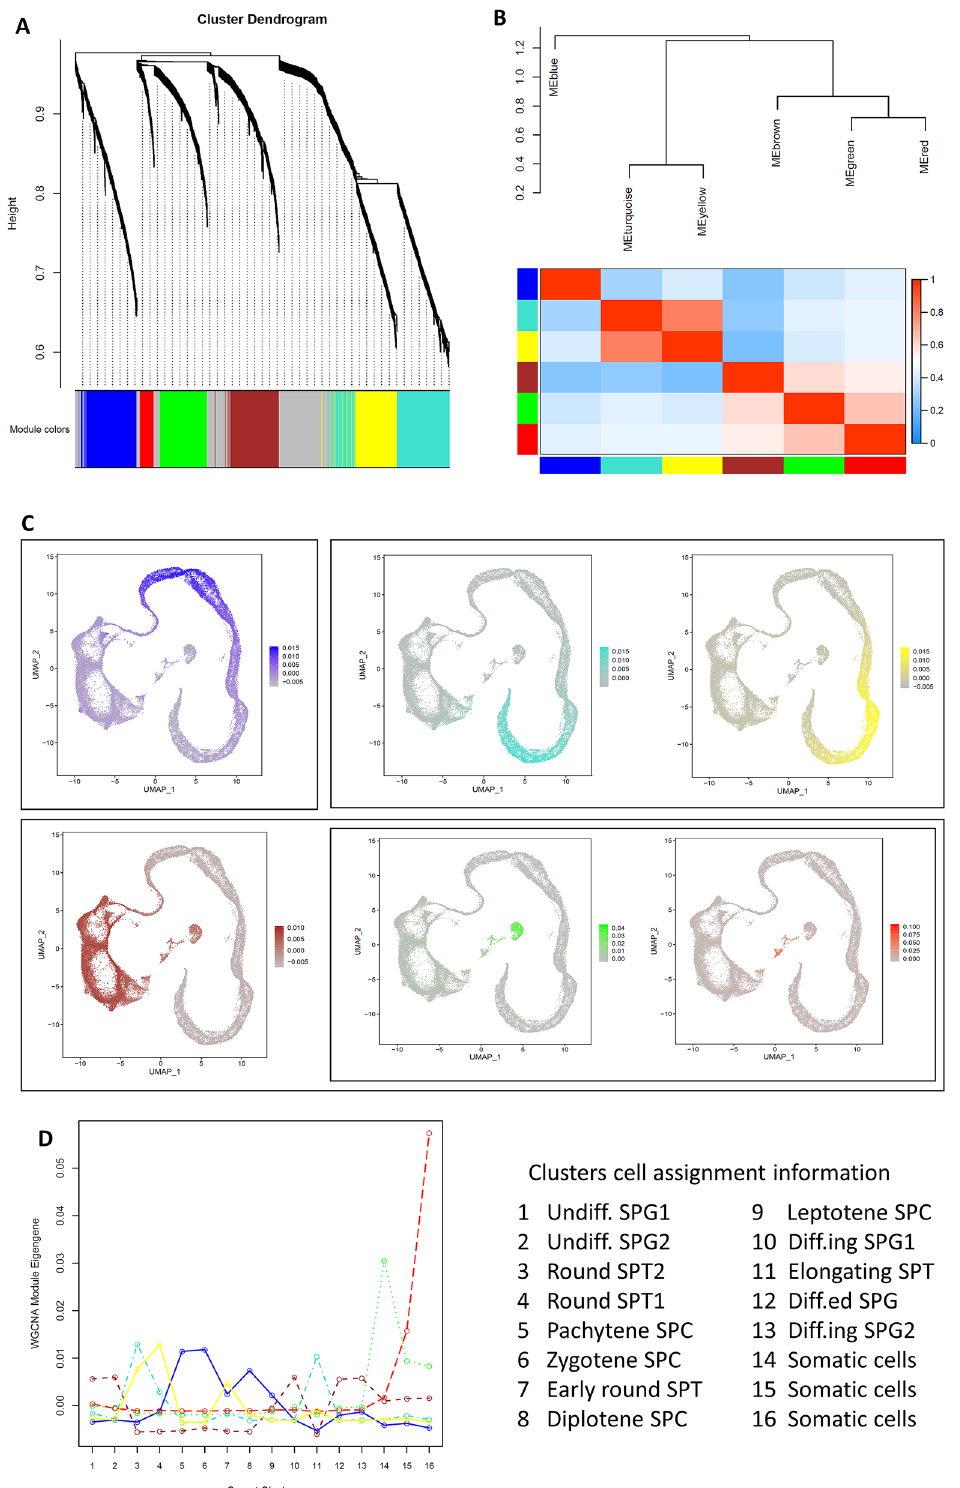
Figure 4. Weighted gene co-expression network analysis. ( A ) The clustering dendrogram of the weighted gene co-expression network. The resulted modules are depicted in different colors of blue, turquoise, yellow, brown, green, red, and gray. The gray modules gene lacked similar co-expression to other genes which were removed from more analysis. ( B ) the eigengene dendrogram and eigengene adjacency heatmap of modules, ( C ) the gene expression patterns on the UMAP space for each module with their corresponding colors, ( D ) the eigengene of each module in each